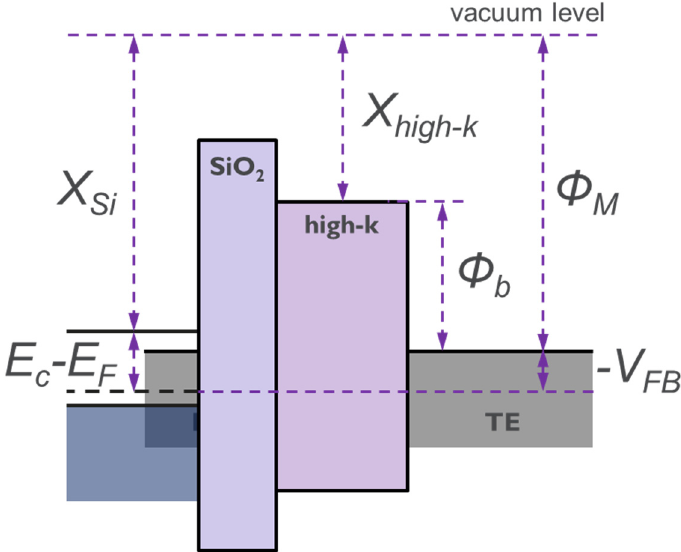
Figure 2. Schematic of the energy band diagram of a metal-insulator-semiconductor (MIS) capacitor.